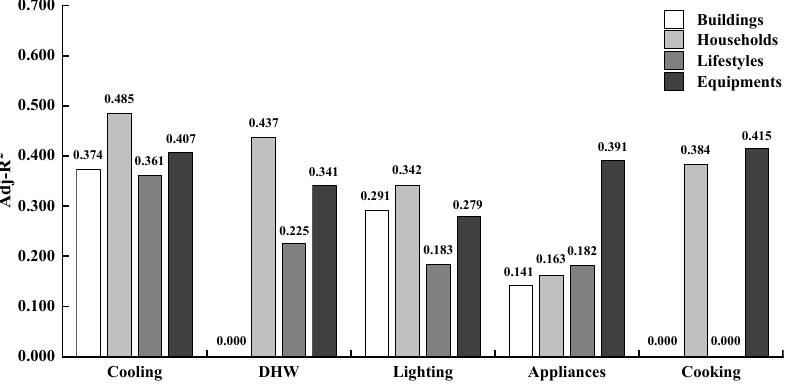
Figure 10. The Adj-R 2 of models 2–5 for five end-use energy